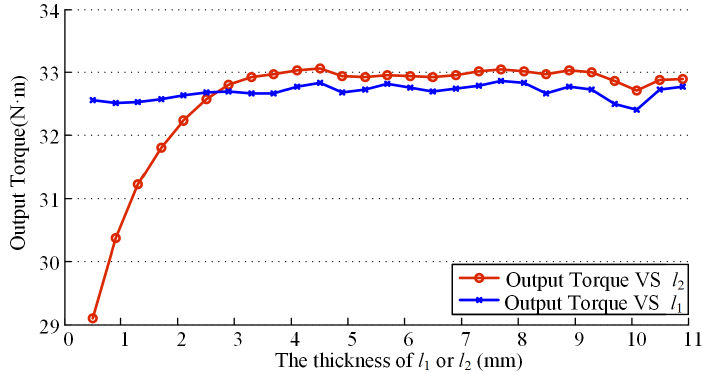
Figure 4. Output torque versus the thickness of l 1 and l 2 .